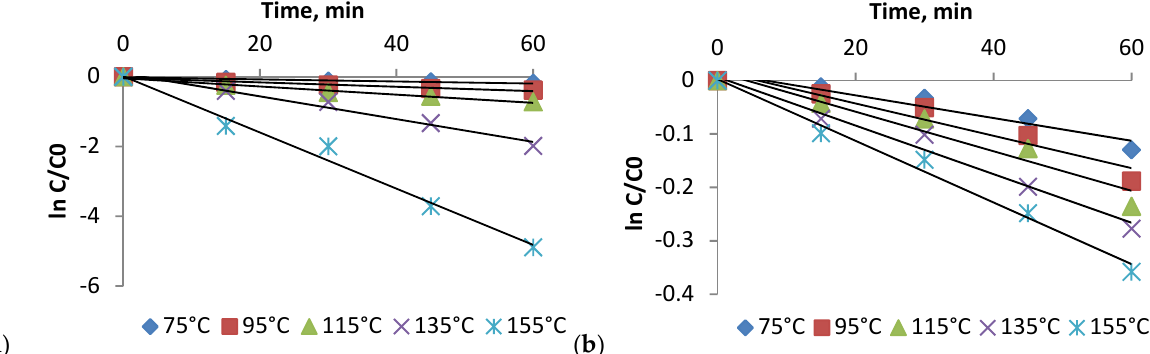
Figure 2. Thermal degradation kinetics of TAC ( a ) and antioxidant activity ( b ) of red onion skin extract that was treated at different temperatures ( 75 °C, 95 °C, 115 °C, 135 °C, 155 °C); C 0 and C are the TAC or antioxidant activity before and after thermal treatment (mg/g dw).